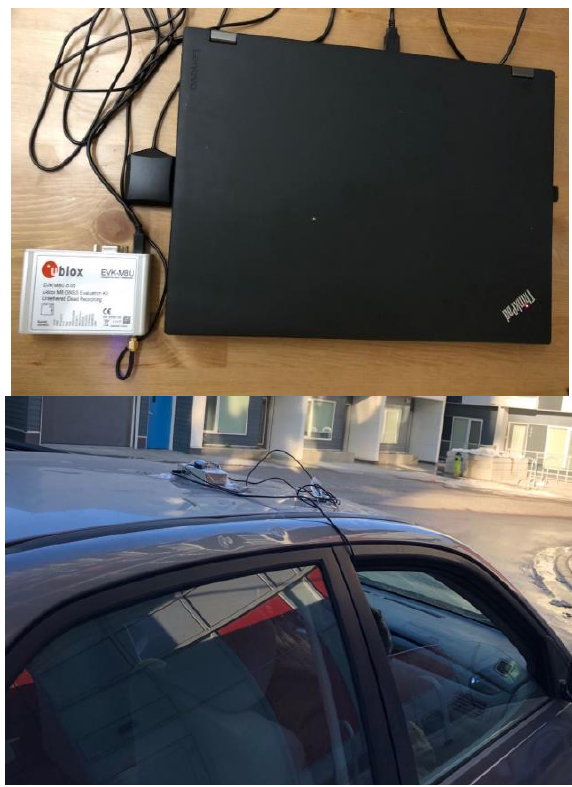
Figure 1. Field test equipment and setup: One Ublox EVK-M8U and one patch antenna mounted on the vehicle roof were used in the tests. A laptop was used to store the datasets. The antenna was mounted directly on the EVK-M8U, and the level arm was neglected.